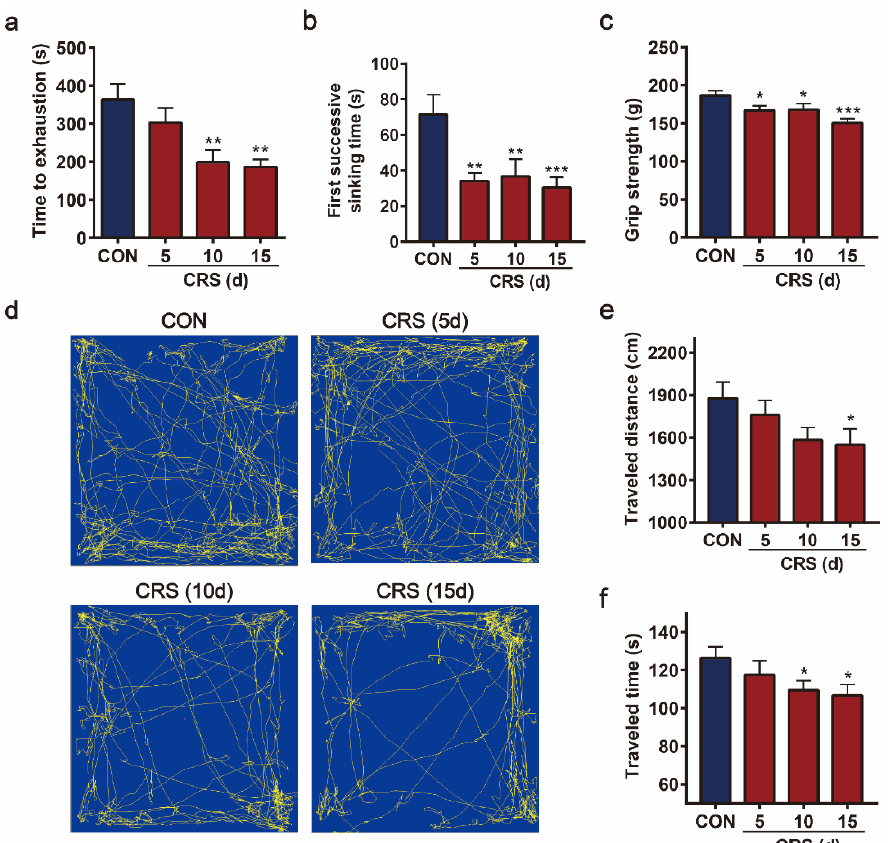
Figure 2. The effects of CRS on the behaviors of mice in the exhaustive swimming test (EST), grip strength test (GST), and open field test (OFT). Exhaustion time ( a ) and first successive sinking time ( b ) in EST. Grip strength in GST ( c ). Motion trail ( d ), traveled distance ( e ), and traveled time ( f ) in the OFT. Data are presented as the mean ± SEM (n = 10–12), * p < 0.05, ** p < 0.01, *** p < 0.001.